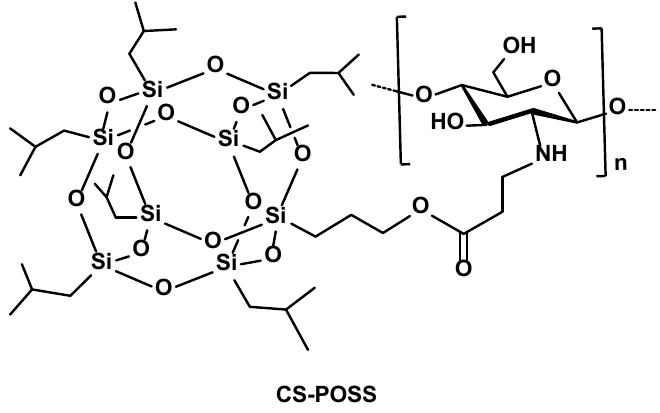
Figure 1. Structure of CS-POSS.